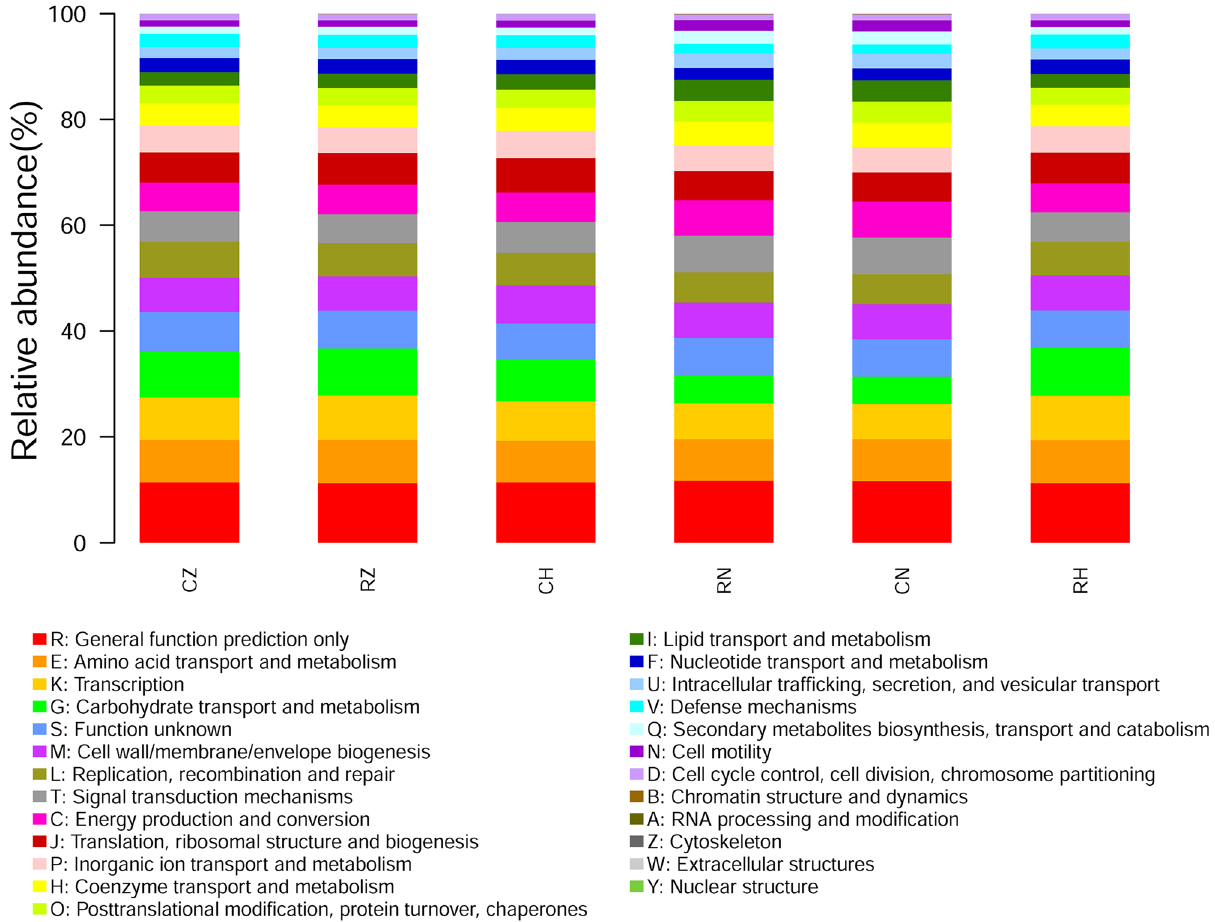
Figure 7. The COG function classification of the six